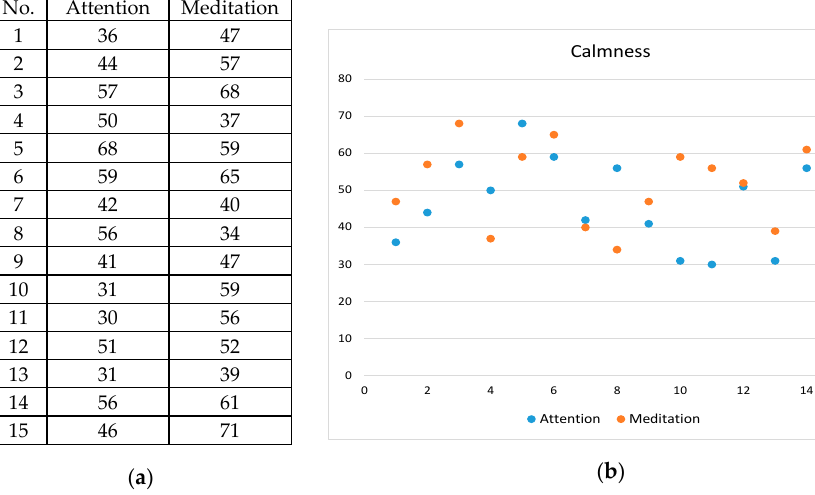
Figure 7. The data and the distribution graph of the average values of the 15 measured two-feature sample sequences of the emotion type of calmness from which the corresponding decision rule 30 ≤ a < 70 and 30 ≤ m < 70 for emotion classification is inferred, where a and m represent the attention and meditation signals, respectively. ( a ) The average data. ( b ) The graph.